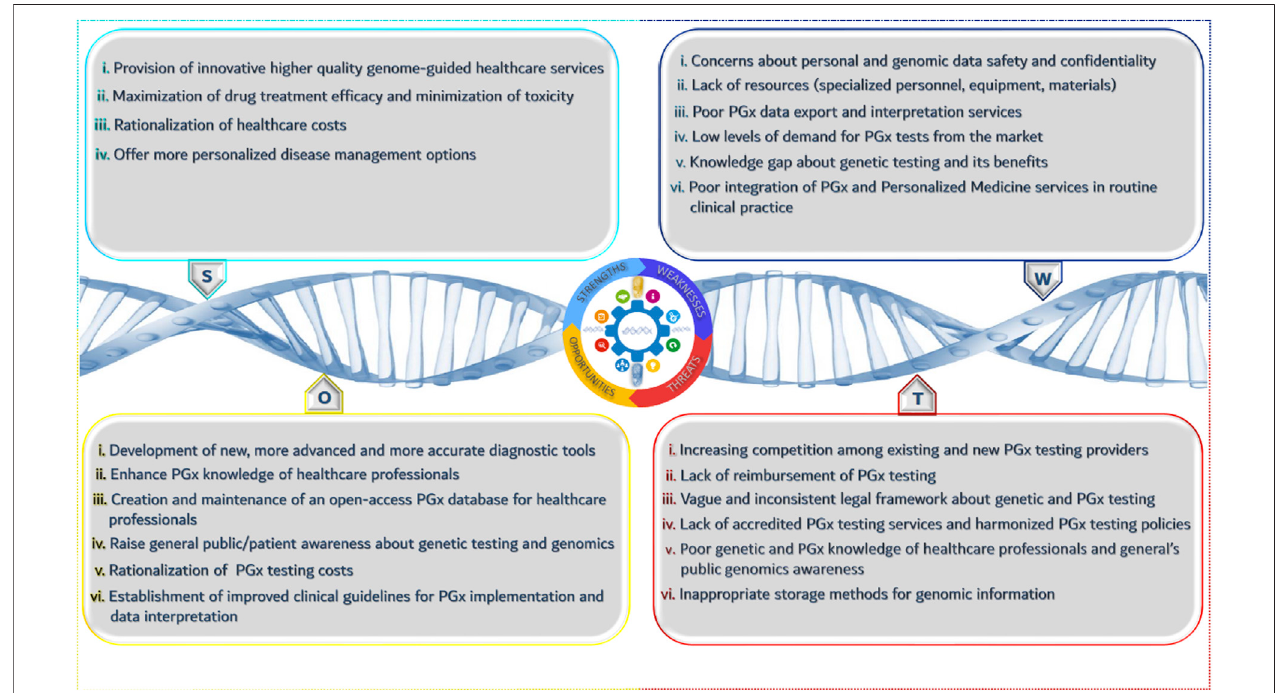
FIGURE 1 | SWOT analysis for the implementation of PGx services by healthcare